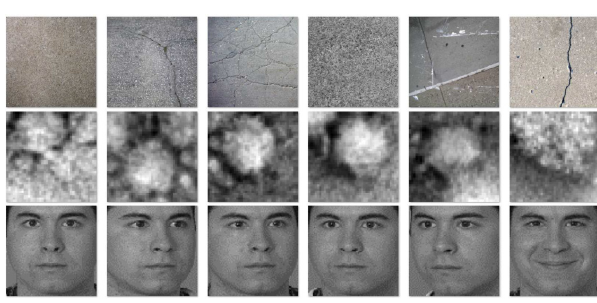
Fig. 3 Several image samples from 3 different datasets: UIUC Material, Virus, and